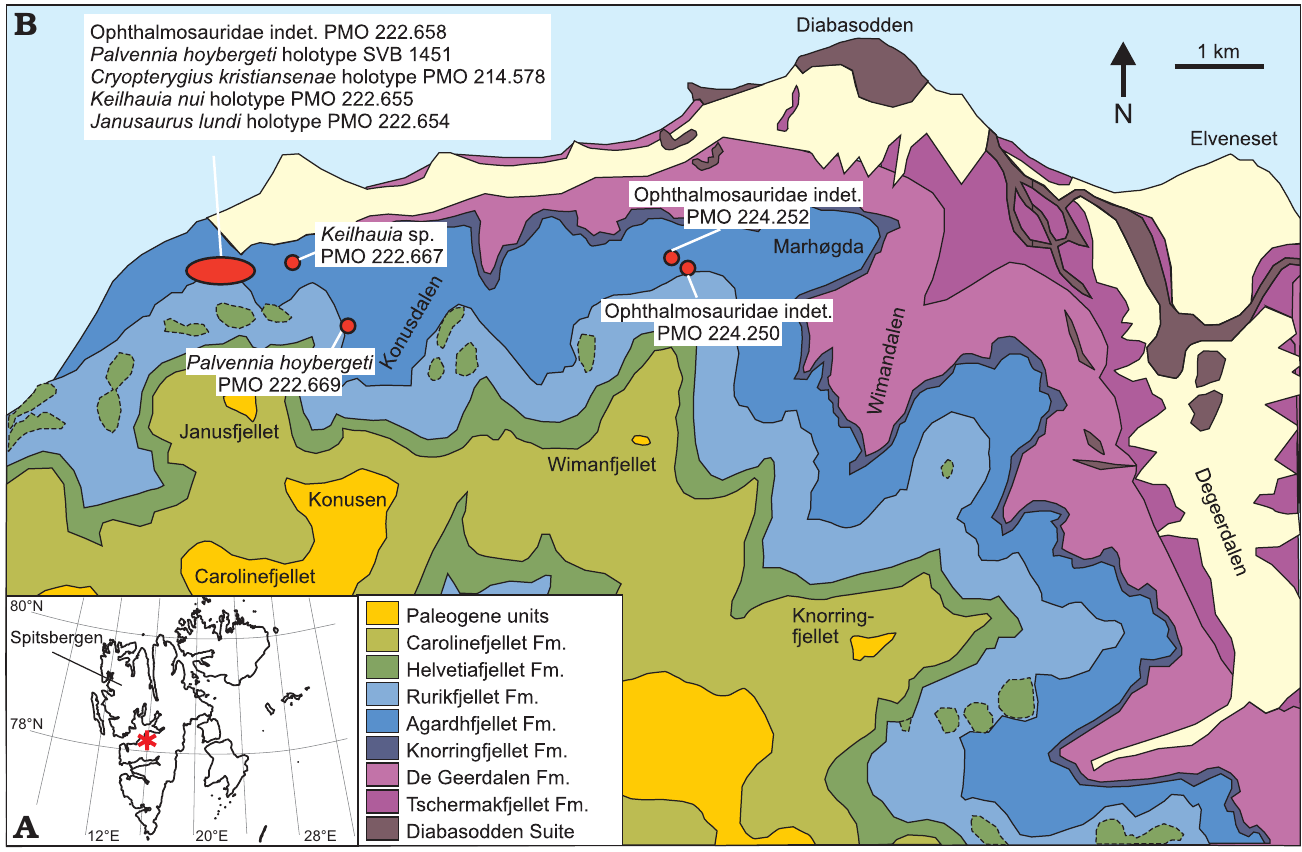
Fig. 1. A . Map of Svalbard archipelago and the main island Spitsbergen with excavation area marked with an asterisk. B . Geological map of the excavation sites for the SML ophthalmosaurid specimens described and discussed in this paper (red dots); see Fig. 2. Adapted from Hurum et al.